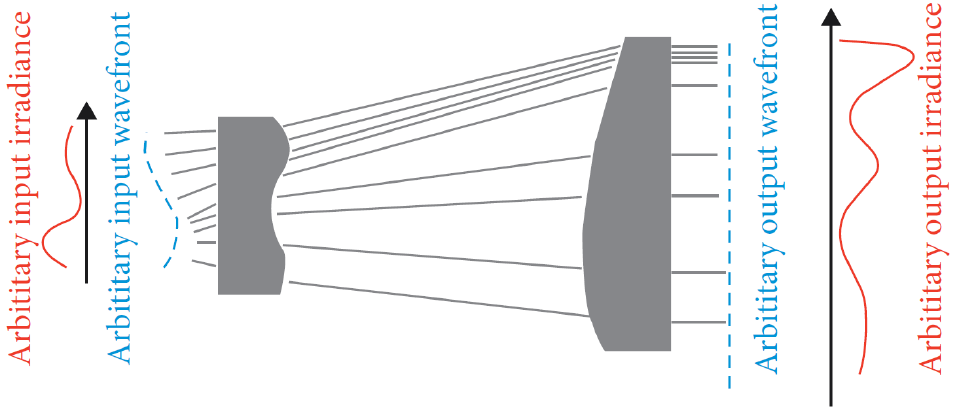
Figure 2. Beam shaper for arbitrary input/output beams. The freeform surfaces perform irradiation conversion — the first freeform lens that on the left; wavefront correction — the second lens that on the right [80].